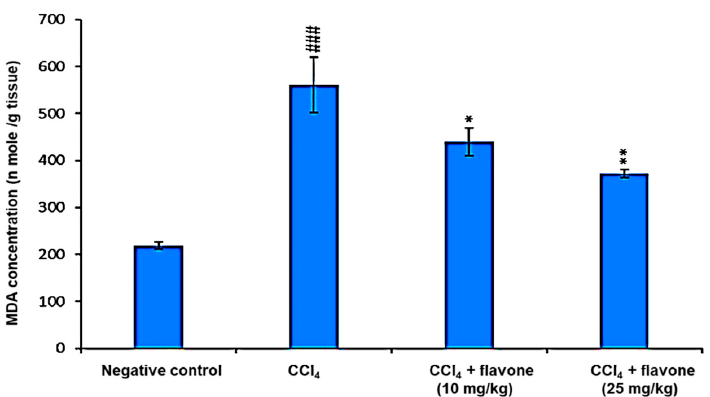
Figure 3. Effect of the flavone on MDA level in liver tissue homogenates. Data are presented as mean ± SD. Significantly ( ### p < 0.001) different from normal control group. Significantly (* p < 0.05, ** p < 0.01) different from CCl 4 model group. MDA: malonaldehyde.